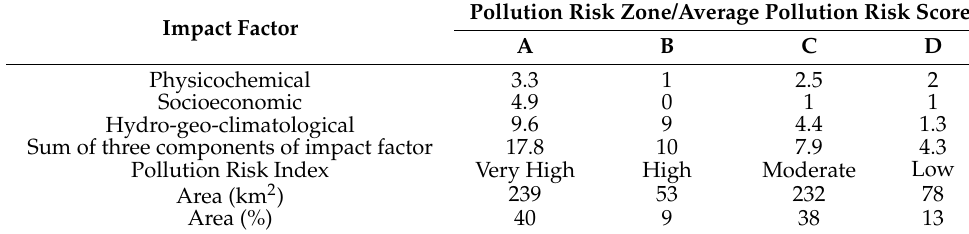
Table 3. The parameters scoring system adopted for the evaluation and calculation of pollution risk score of each zone and index of each zone and associated areas (km 2 and %) adopted by the authors for a multilayered aquifer system of